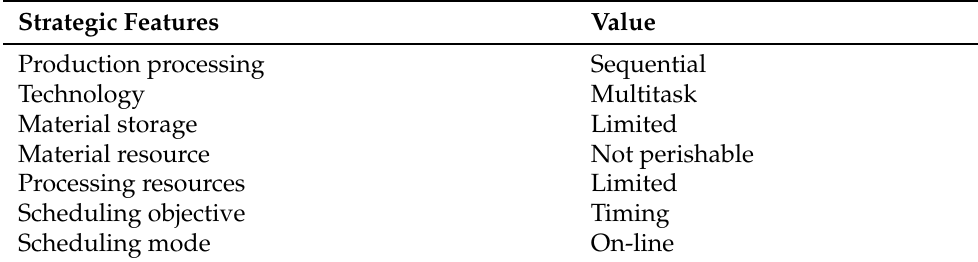
Table 4. Strategic features of the organization for system